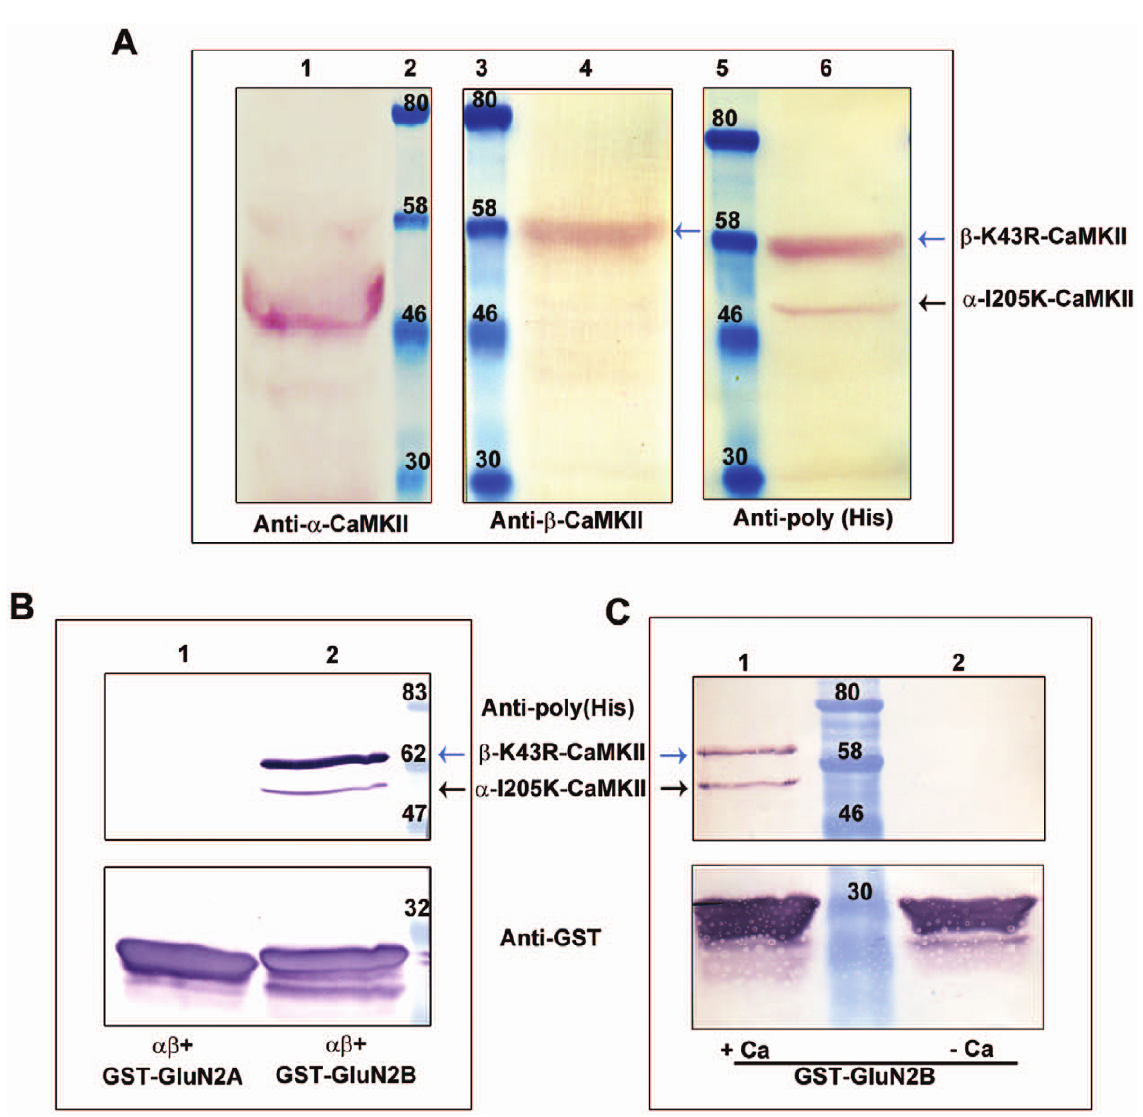
Figure 2. GST-pull down assay shows that a -I205K-CaMKII and b -K43R-CaMKII can form heteromultimers. The mutants, a -I205K-CaMKII and b -K43R-CaMKII, when expressed from a single vector, form heteromultimers and are pulled down by GST-GluN2B. A: Western blot of ( a - I205K)-( b -K43R)-CaMKII expressed in insect cell line. The heteromeric CaMKII was prepared by coexpressing GluN2B binding defective a - subunits (I205K) with b -subunit defective in nucleotide binding (K43R) using pFastBac TM Dual vector. Both the CaMKII mutants were His-tagged at their N-terminii. Lane 2, 3 and 5: Molecular weight marker; Lane 1: Lysate (50 m g) expressing heteromer probed with anti- a -CaMKII antibody; Lane 4: Lysate (50 m g) expressing heteromer probed with anti- b -CaMKII antibody; Lane 6: Lysate (50 m g) expressing heteromer probed with anti-(poly) His antibody. The arrows indicate the positions of a and b subunits in each lane. B: Heteromeric CaMKII binds specifically to GST-GluN2B. Western blot following GST pull down assay of the heteromeric CaMKII mutant is shown. GST-Pull down assays were done with crude cell lysates of fusion proteins and heteromeric CaMKII. Upper panel was probed with anti-(poly) His antibody and lower panel was probed with anti-GST antibody. Lane 1: Pull down with GST-GluN2A; Lane 2: Pull down with GST-GluN2B. Data represents 4 experiments. C: GluN2B binding of heteromeric CaMKII is calcium dependent. Western blot following GST pull down assay of the heteromeric CaMKII mutant with GST- GluN2B is shown. GST- Pull down assays were done with crude cell lysates of fusion proteins and heteromeric CaMKII. Upper panel was probed with anti-(poly) His Antibody and lower panel was probed with anti- GST antibody. Lane 1: Pull down in presence of Ca 2 + ; Lane 2: Pull down in the absence of Ca 2 + . Data represents 3